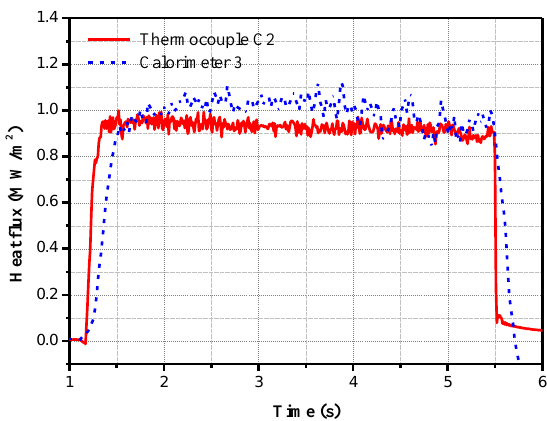
Figure 17. Heat flux obtained from the coaxial thermocouple (C2) and the copper calorimeter (3).